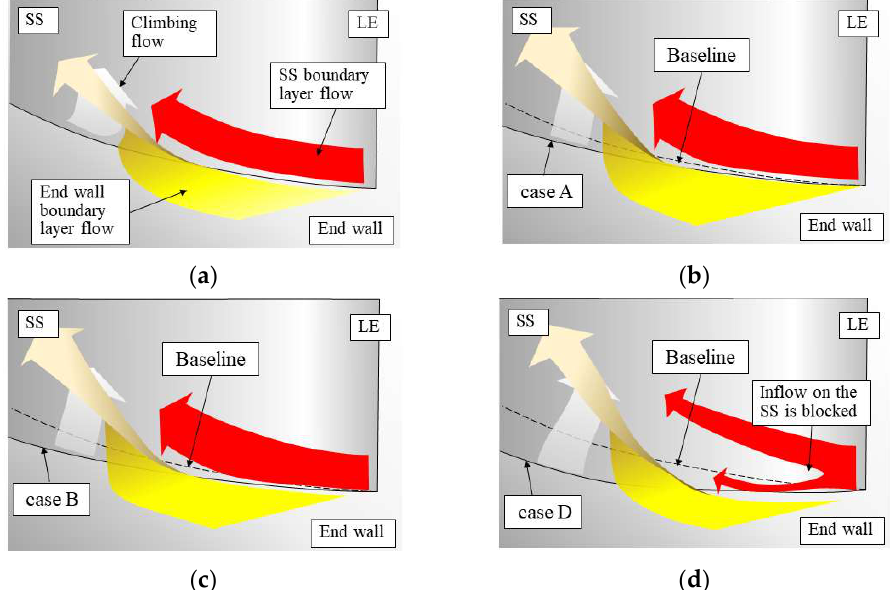
Figure 15. Sketched three-dimensional flow at the design point. ( a ) Baseline; ( b ) case A; ( c ) case B; ( d ) case D.